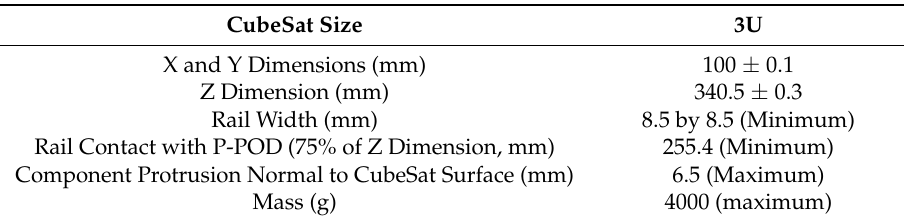
Table 4. 3U CubeSat Dimensions